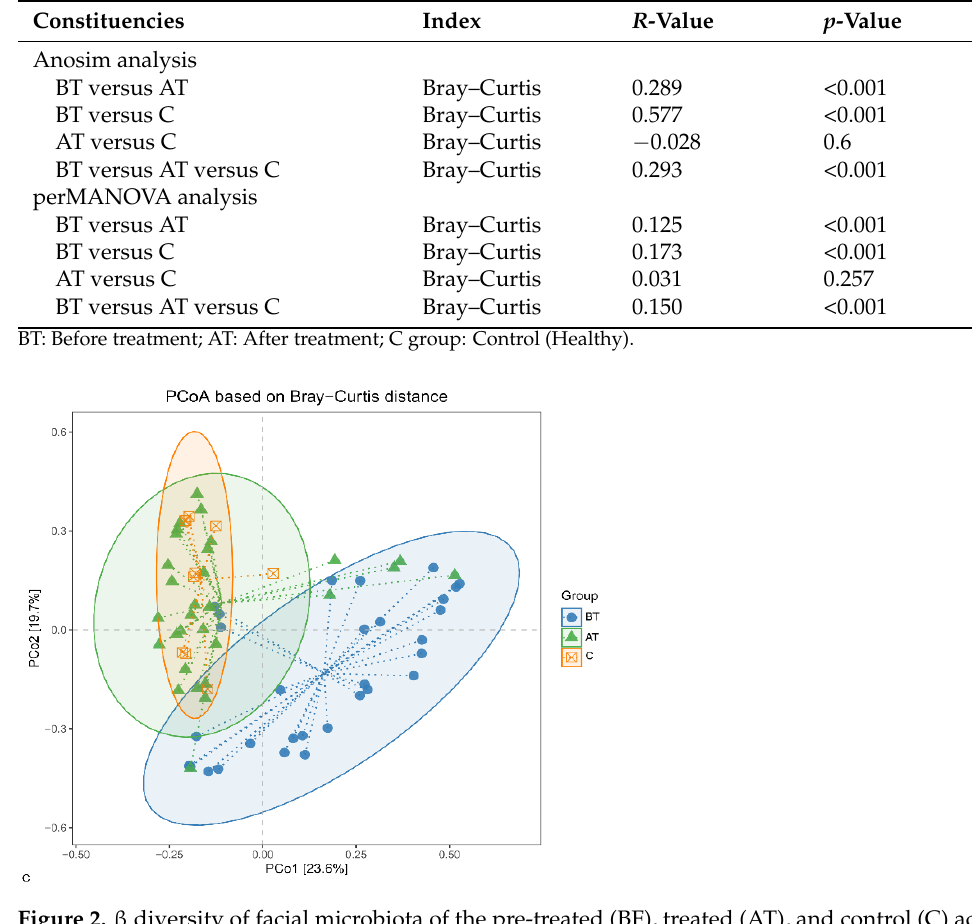
Figure 2. β diversity of facial microbiota of the pre-treated (BF), treated (AT), and control (C) acne groups. Principal Coordinates Analysis (PCoA) based on the Bray–Curtis distance matrix showed a marked separation between the microbial communities of BT and AT group, between BT and C group, in the case of AT and C group degree of separation is comparatively less.